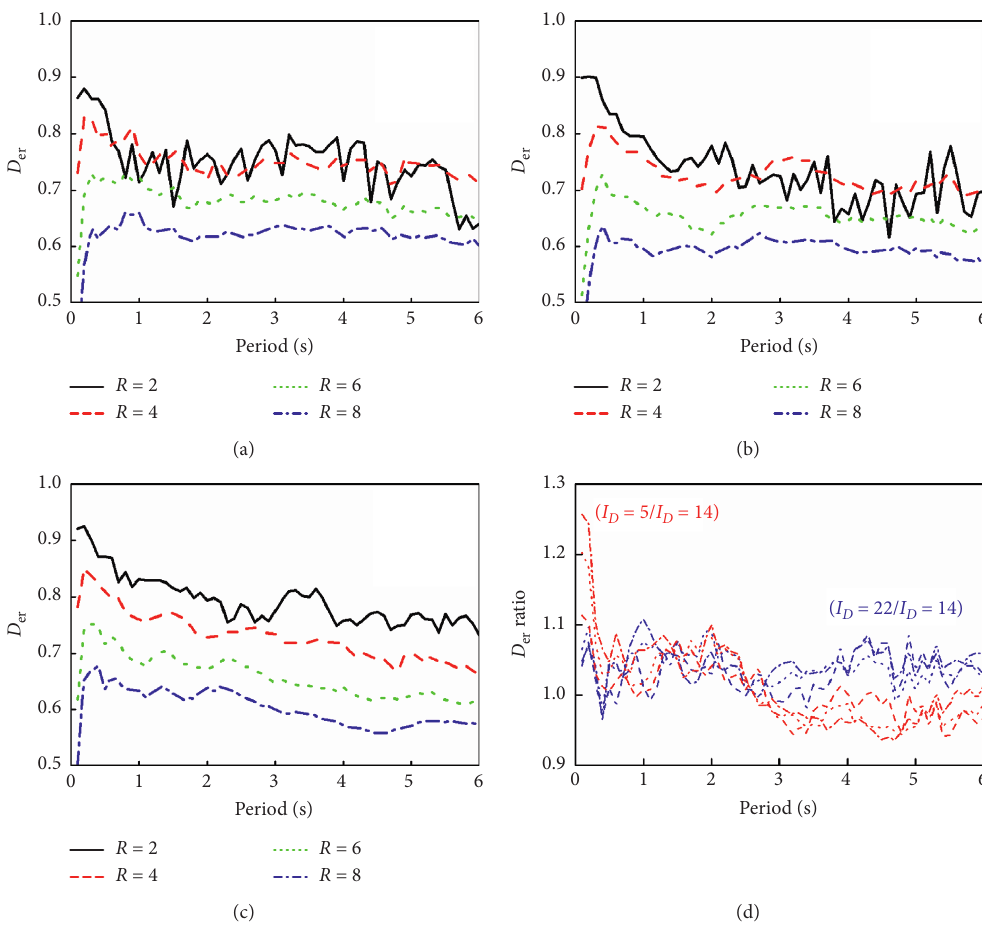
Figure 2: Duration spectrum for different ground motion durations. (a) I